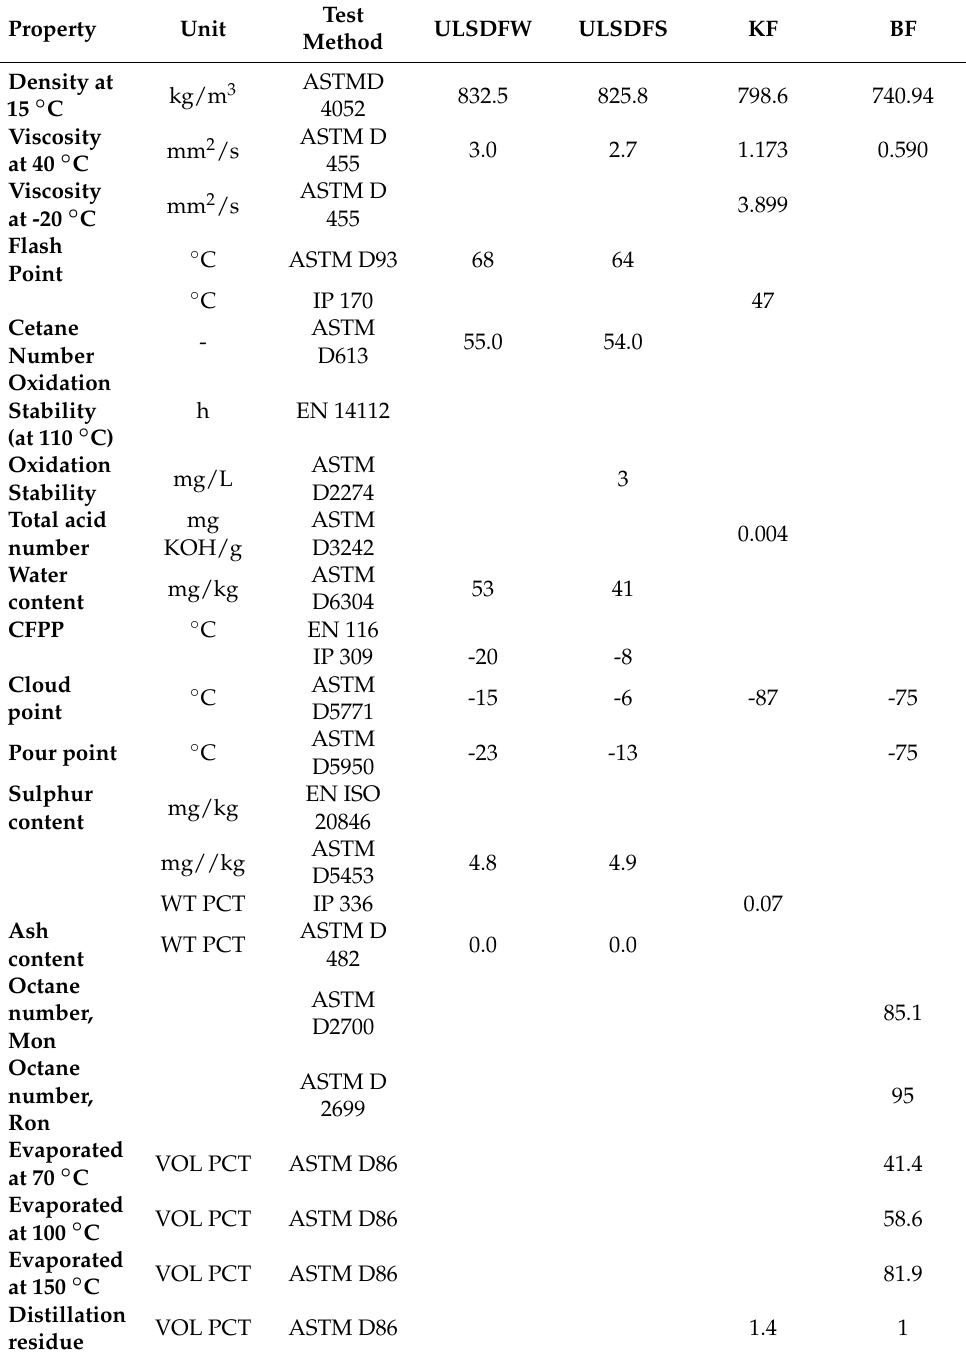
Table 2. Selected physicochemical properties of tested